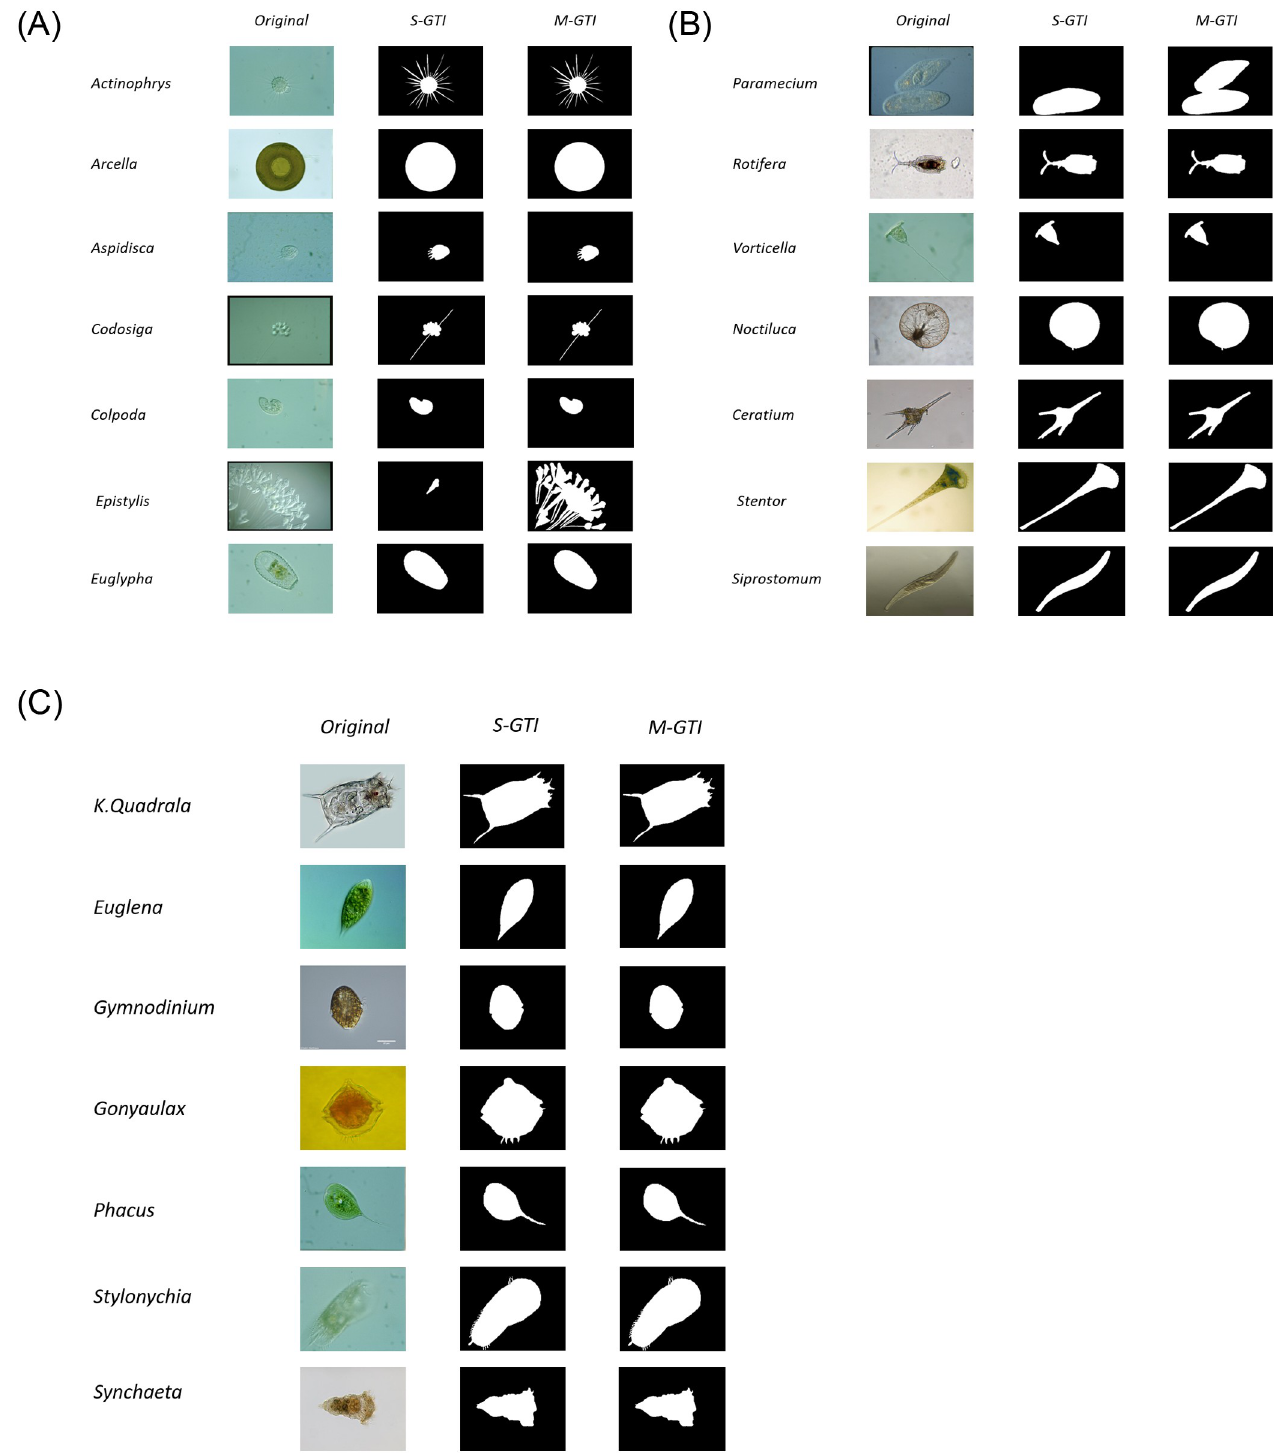
Fig 2. An example of 21 EM classes in EMDS-5. Single-object GT images (SGI), Multi-object GT images (MGI).